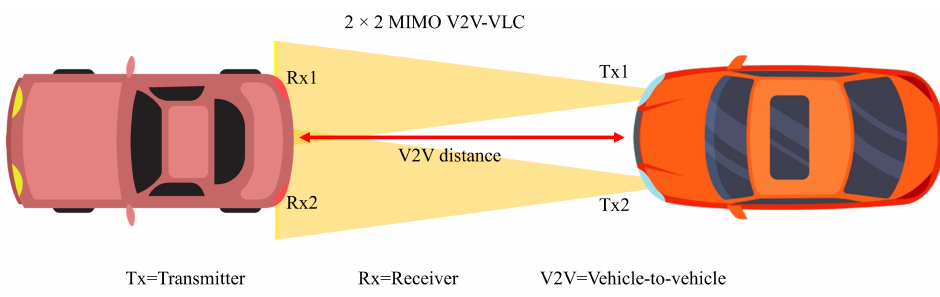
Figure 10. 2 × 2 vehicle-to-vehicle MIMO VLC